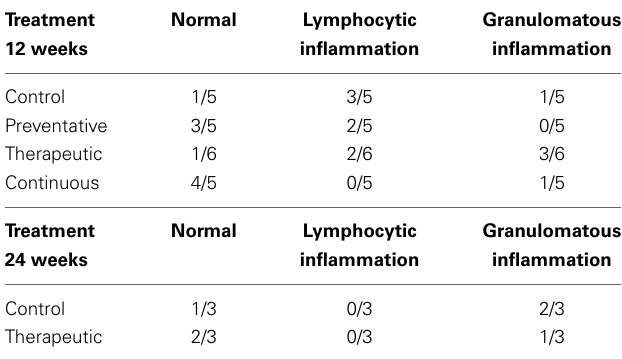
Table 1 | Liver pathology results from different Lactobacillus casei ATCC 334 treatments at 12 and 24 weeks post oral M. avium subsp. paratuberculosis K10